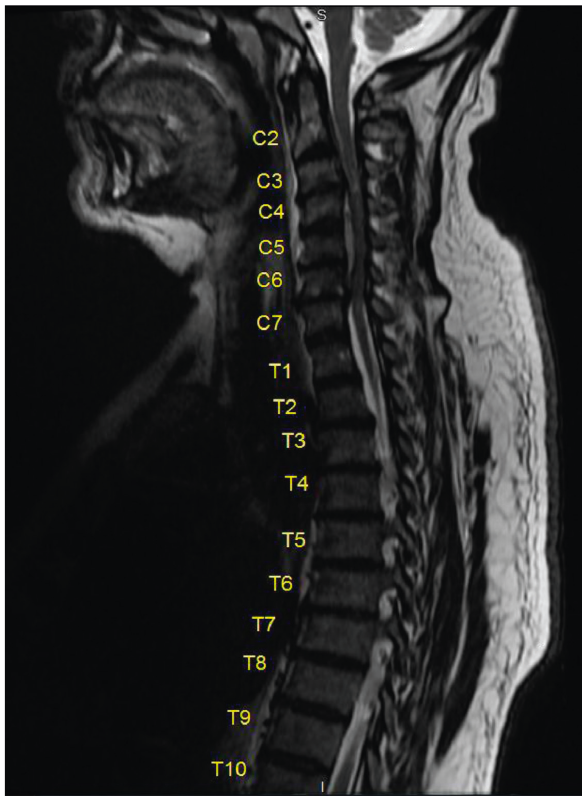
Figure 1: MRI with contrast of spine shows peripherally en- hancing, approximately 1.2 × 4.6 cm, T2 hyperintensity/T1-hypo- intense collection that is located along the posterior vertebral bodies